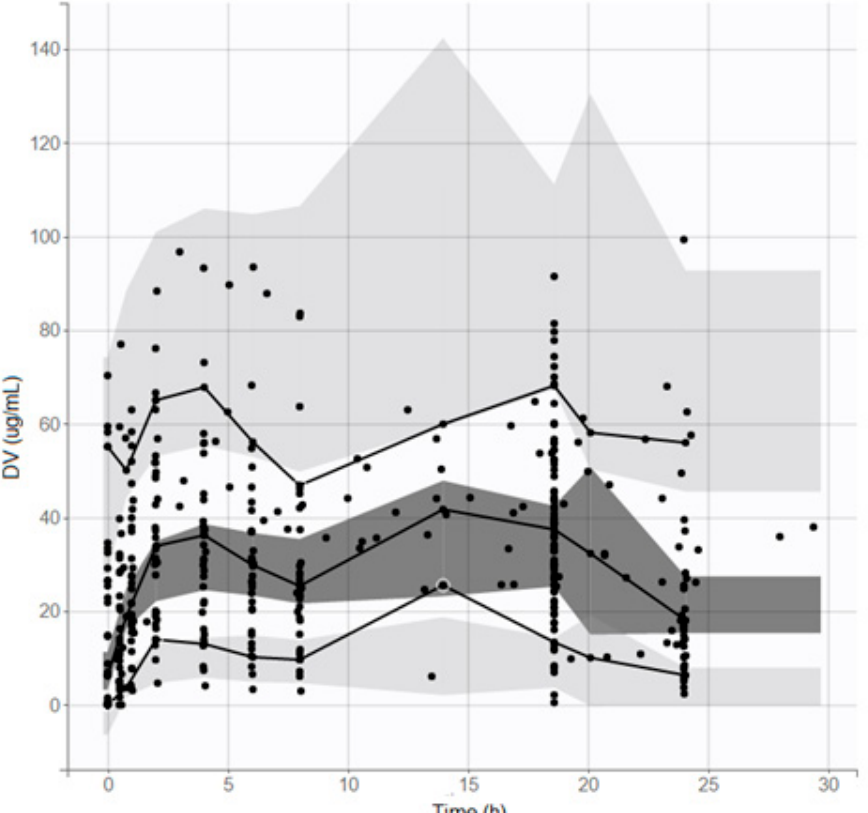
Figure 2. Visual predictive check.